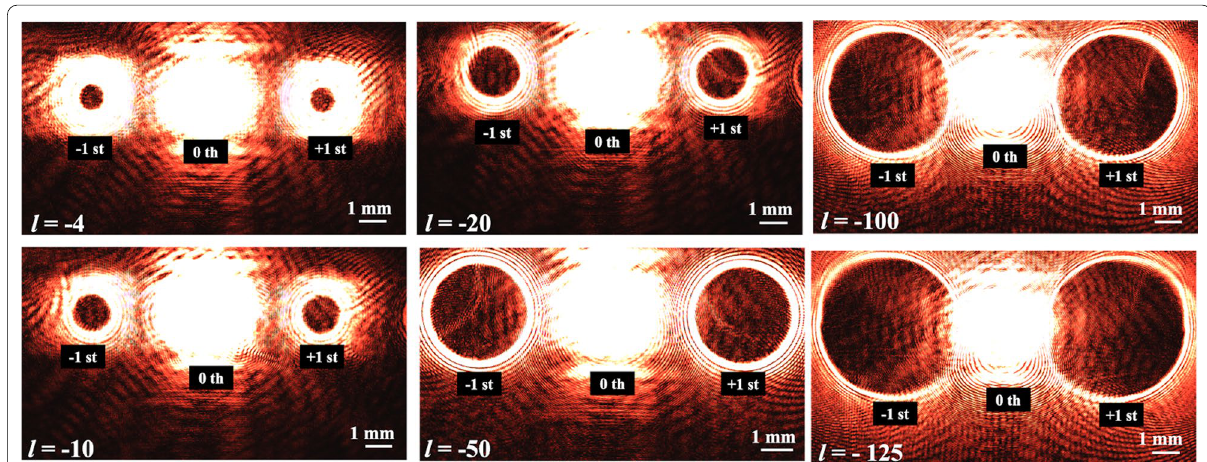
Fig. 10 Reconstructions from single optical vortex beam generating holograms captured using a CCD sensor. The images show the 0th, reconstructed diffraction orders for different topological charges (see embedded label for